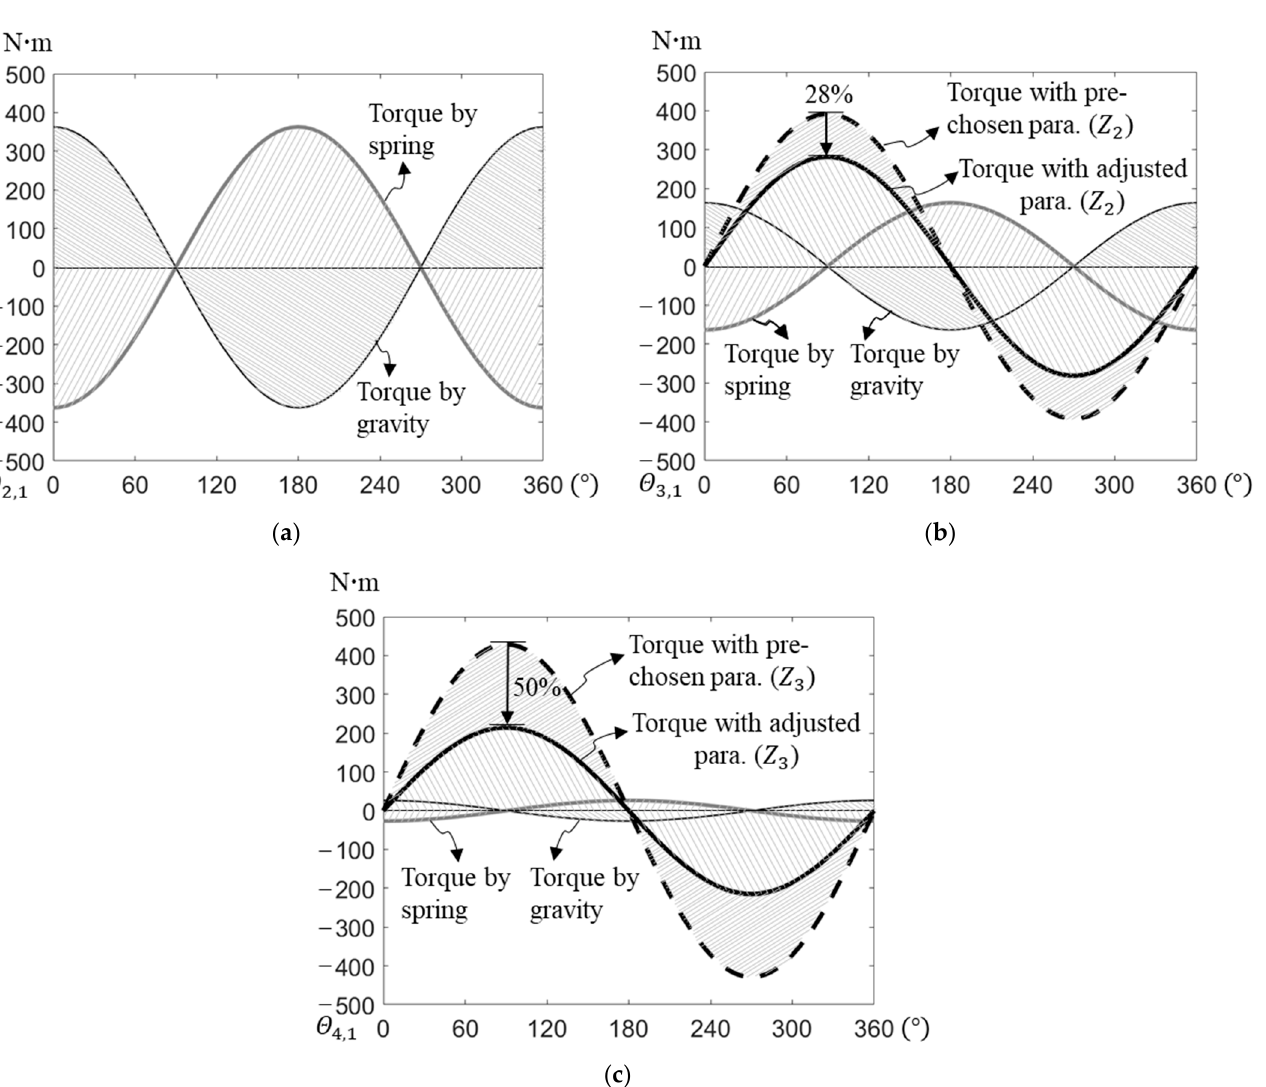
Figure 5. Gravitational torque, torque caused by springs balancing gravitational torque and internal counter-torque at ( a ) joint 1, ( b ) joint 2, and ( c ) joint 3.